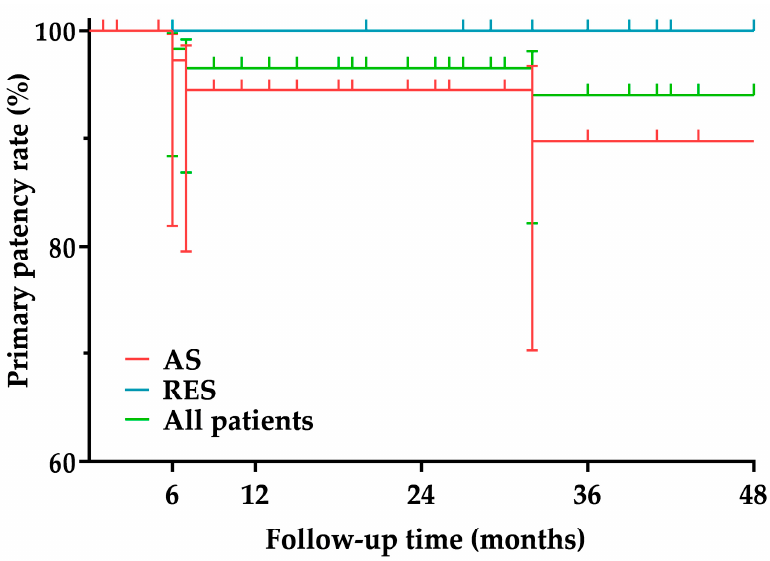
Figure 1. Primary patency. AS, Atherosclerotic; RES, restenotic.